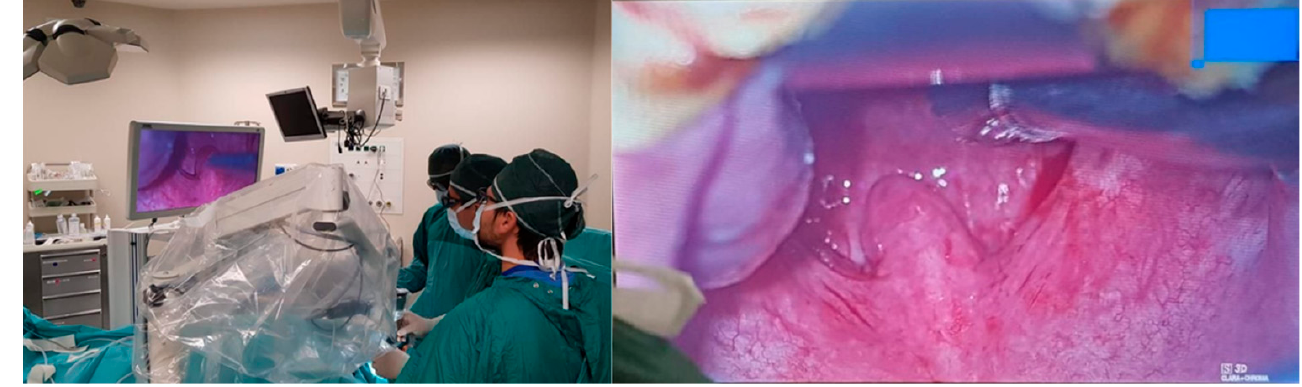
Figure 2. Intraoperative view of oropharynx.